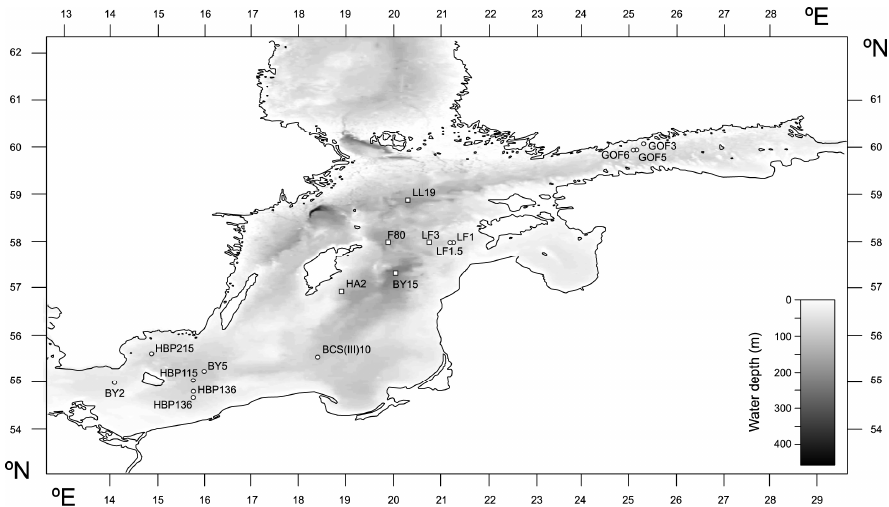
Fig. 1. Bathymetric map of the Baltic Proper, showing the locations of the coring sites used in this study. Circles represent Group 1 sites ( ≤ 90m water depth), squares represent Group 2 sites ( > 90m water depth). Bathymetric and coastline data are presented in equidistant cylindrical projection, taken from the General Bathymetric Chart of the Oceans (GEBCO) Digital Atlas (Intergovernmental Oceanographic Commission et al. 2003).